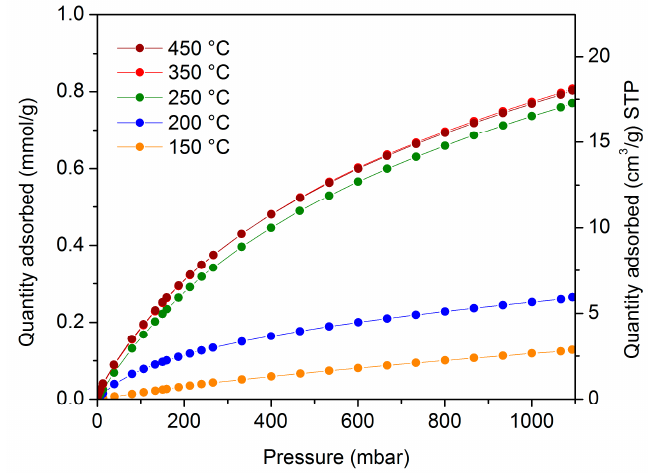
Figure 7. CO 2 Adsorption isotherms at 25 °C on Ce 5 (BDC) 7.5 (DMF) 4 at different activation temperatures (150 °C, 200 °C, 250 °C, 350 °C, 450 °C).